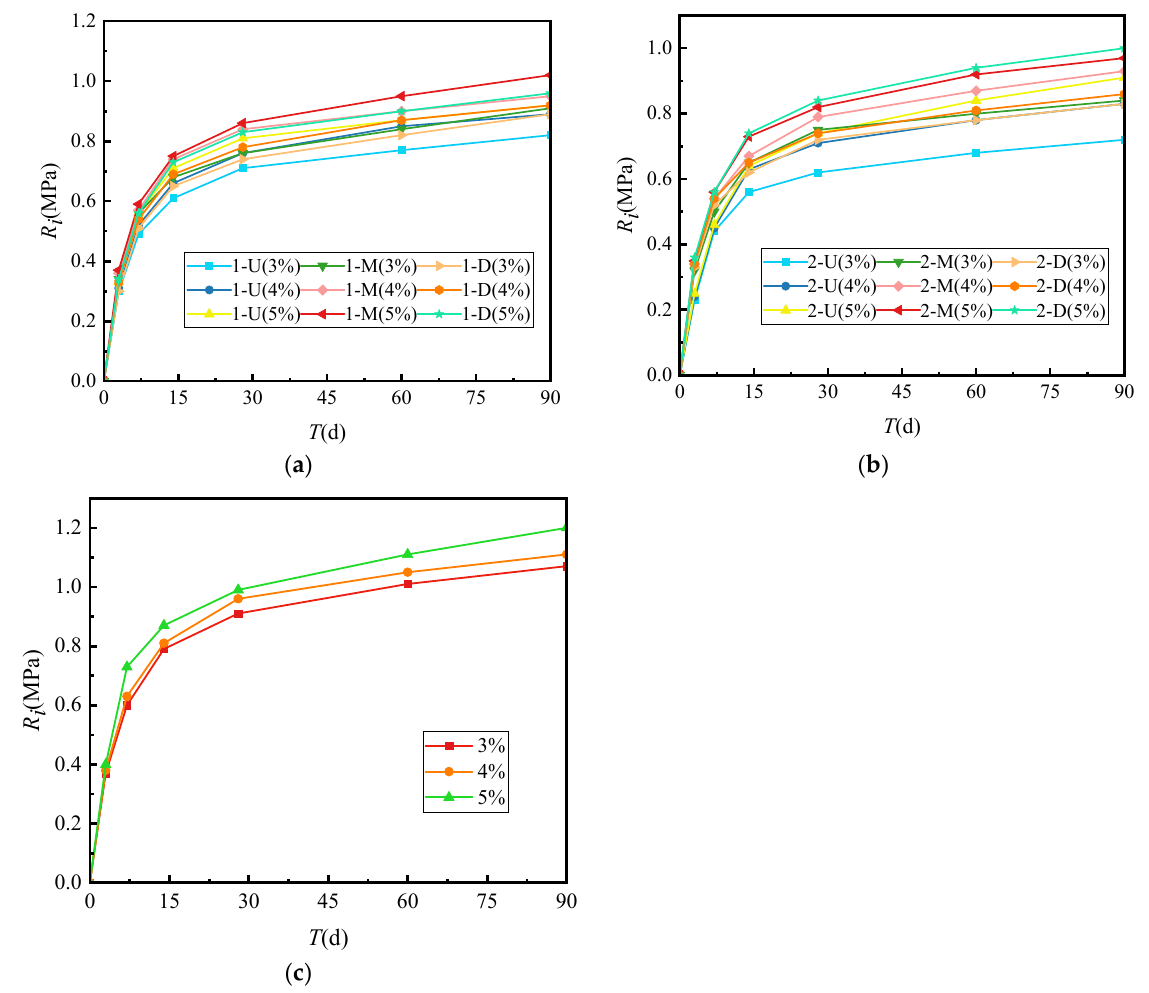
Figure 3. Growth law of splitting strength. ( a ) GF1, ( b ) GF2, ( c ) VGM-30. Figure 3 shows that the R i growth law of cement-graded crushed stone of several types was similar to that of unconfined compressive strength, and both increase with the increase of curing time. R i had the fastest increase during the first 14 days. The strength at 7 days was approximately 50% of the ultimate strength. After 28 days, the increase in R i gradually slowed to 75% of the ultimate strength. At 90 days, the strength was approximately 90%. After this time, the R i curve approached a horizontal line, and the vertical intercept corresponding to this horizontal line was set as the ultimate splitting strength. At the same age, the splitting strength of VGM-30 > GF1 > GF2. Figure 4 shows the relationship between the growth law and curing times of the resilience modulus ( E e ) of cement-graded crushed stone.